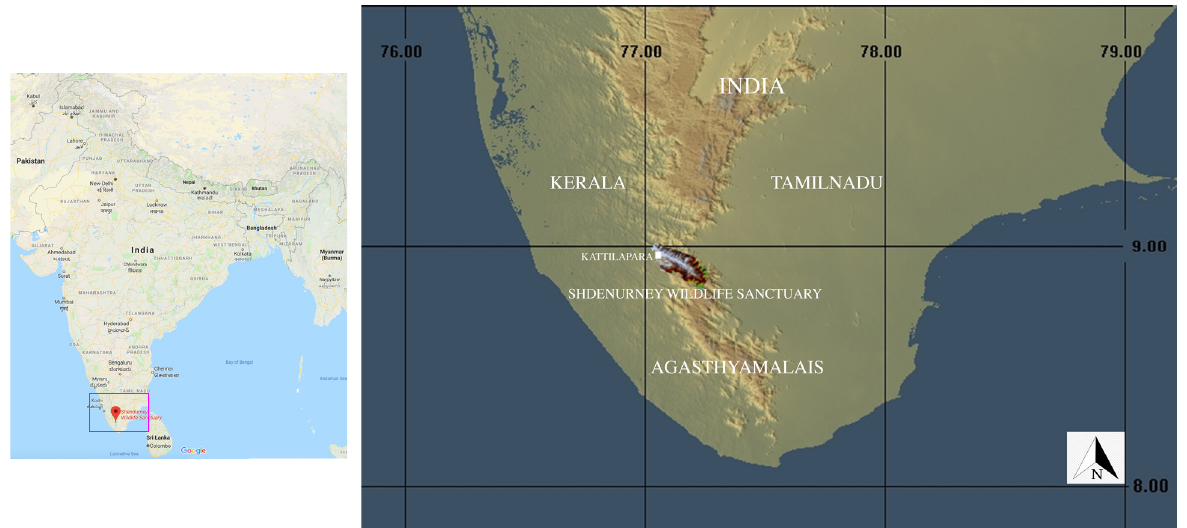
Figure 1. Study area in Shendurney Wildlife Sanctuary, Kerala.